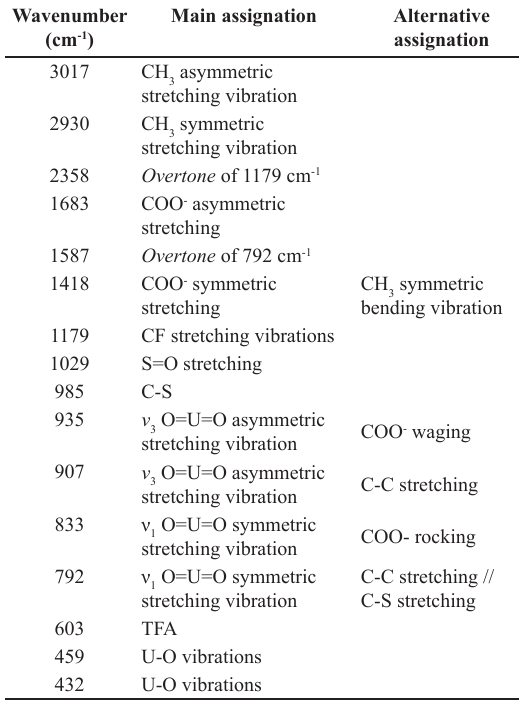
Fig. 6. Emission spectra of [UO at 305 nm ( black ) and at 420 nm ( red ). Table 2. Main absorption bands in the ATR-FTIR spectrum of [UO